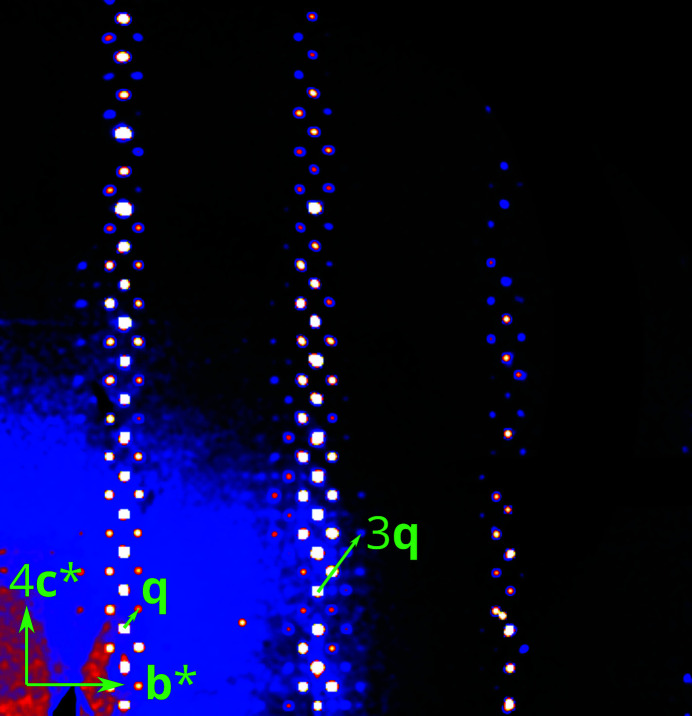
(3kl)* plane of reciprocal space of a crystal of 1 reconstructed from 2D detector data. A first- and a third-order satellite are indicated.